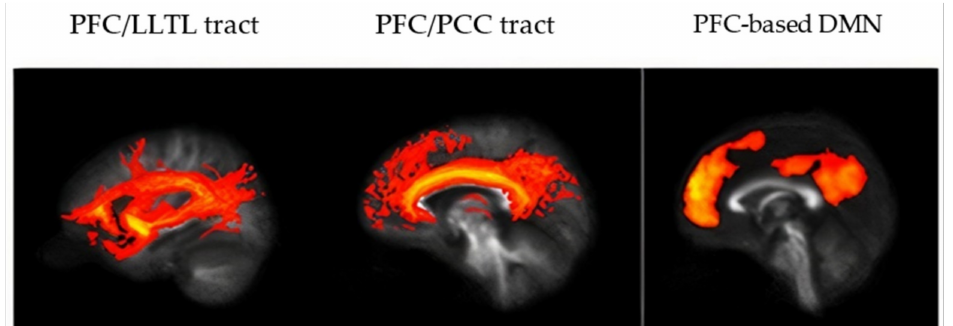
Figure 2. Representative data from a study participant. ( Left ) mean tract connecting PFC and LLTL for controls, ( Middle ) mean tract connecting PFC and PCC for controls, and ( Right ) Seed-based functional connectivity map of the DMN using the PFC ROI in controls, thresholded at RSFC( Z ) = 0.4. Abbreviations are as in Figure